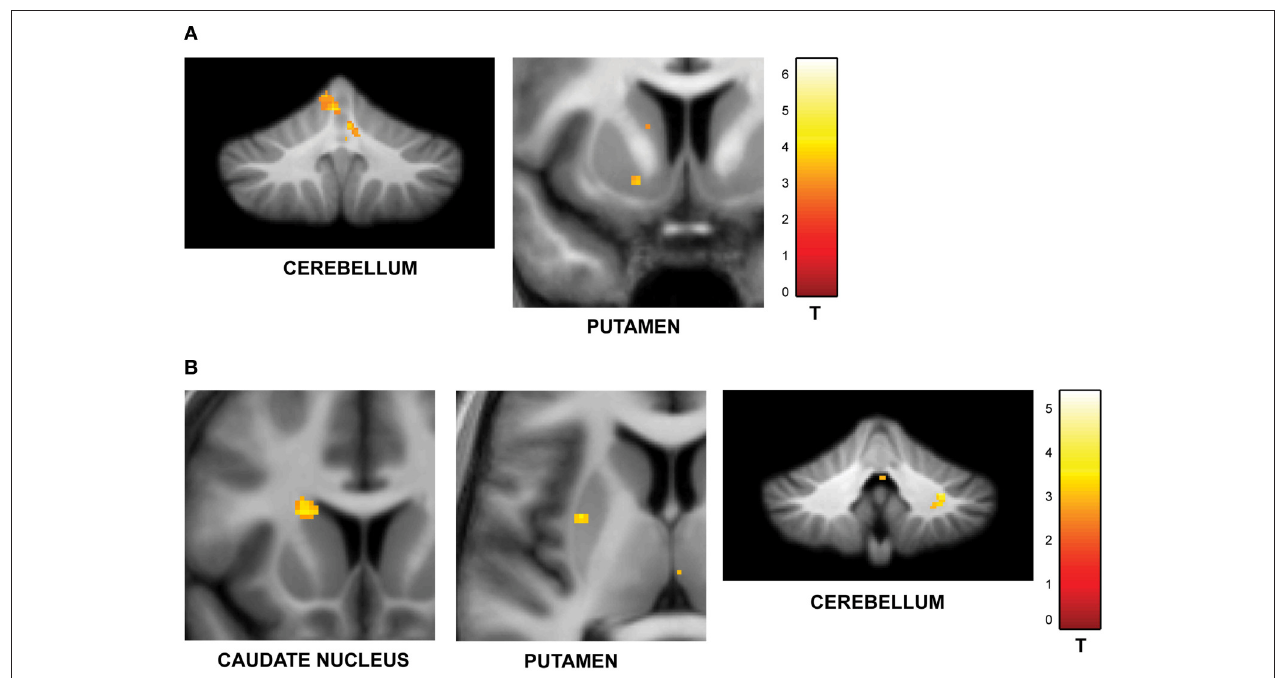
FIGURE 2 | Functional imaging results: effect of jitter. (A) Brain areas that encode temporal memory in the context of irregular sequences. BOLD activations are shown for the vermis and cerebellum (overlaid on the SUIT template of the human cerebellum, Diedrichsen, 2006, Diedrichsen et al., 2009); left putamen and parahippocampal gyrus (overlaid on a coronal section of the average normalized structural scan and zoomed to 80 × 80mm) at a threshold of p < 0.001 (uncorrected, for each figure). Other activations in the precuneus, MTG, and pallidum are listed in Table 1A . The strength of activations ( t -value) is graded according to the adjacent color scheme on the right (for each figure). (B) Brain areas that encode temporal memory in the context of regular sequences. BOLD activations in the striatum including the caudate and putamen as well as the cerebellum are shown. Other activations in the thalamus, temporal pole, and frontal cortex are listed in Table 1B . The significant clusters are displayed according to the same scheme as in Figure 1A .